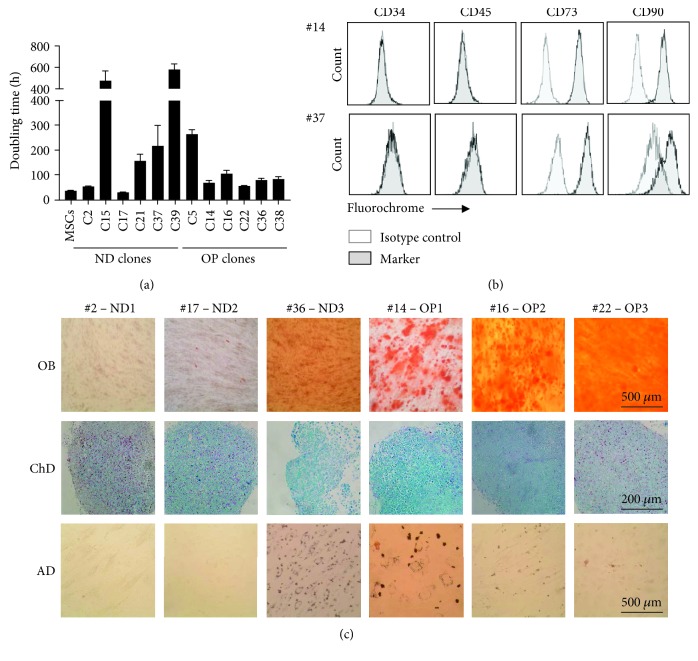
Selection of clones for transcriptome sequencing. Screening of MSC characteristics of 12 clones was performed. (a) Doubling time (h) of parental T-MSCs and clones; data are shown as mean ± SEM. (b) Surface marker expression in clones; representative images show changes in CD90 expression. (c) Clones were induced for OB, chondrogenic (ChD), and AD differentiation and stained with Alizarin red S, Alcian blue, and oil red O staining, respectively (100x magnification for OB and AD, 200x magnification for ChD). Representative images of three ND and three OP clones selected for further analyses were presented.